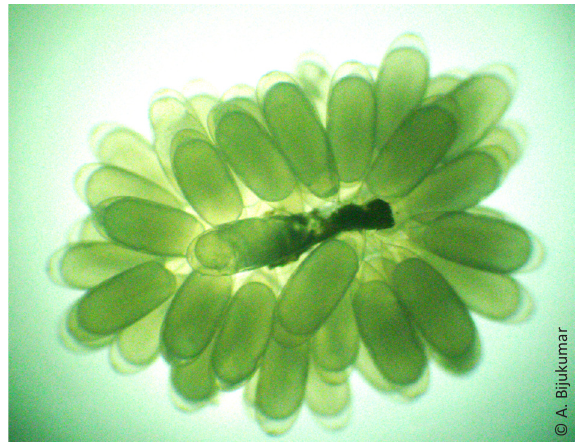
Image 11. Part of egg festoon - a microscopic view